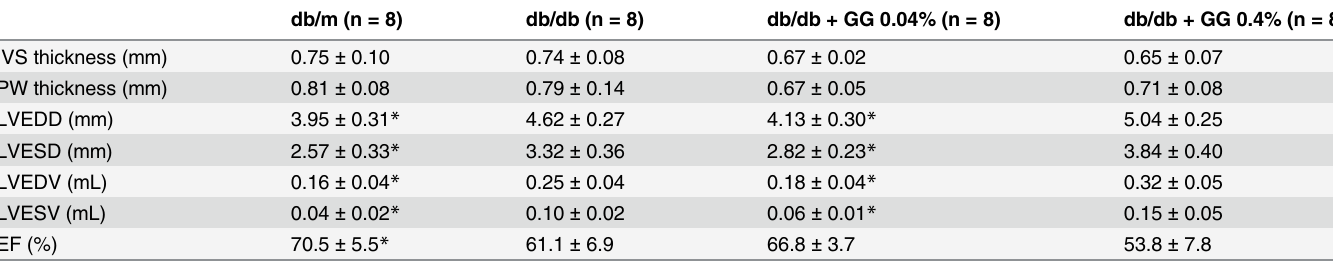
Abbreviation: IVS indicates interventricular septum; PW, posterior wall; LVEDD, left ventricular end-diastolic dimension; LVESD, left ventricular end- systolic dimension; LVEDV, left ventricular end-diastolic volume; LVESV, left ventricular end-systolic volume, EF; ejection fraction. The results are expressed as the mean ±